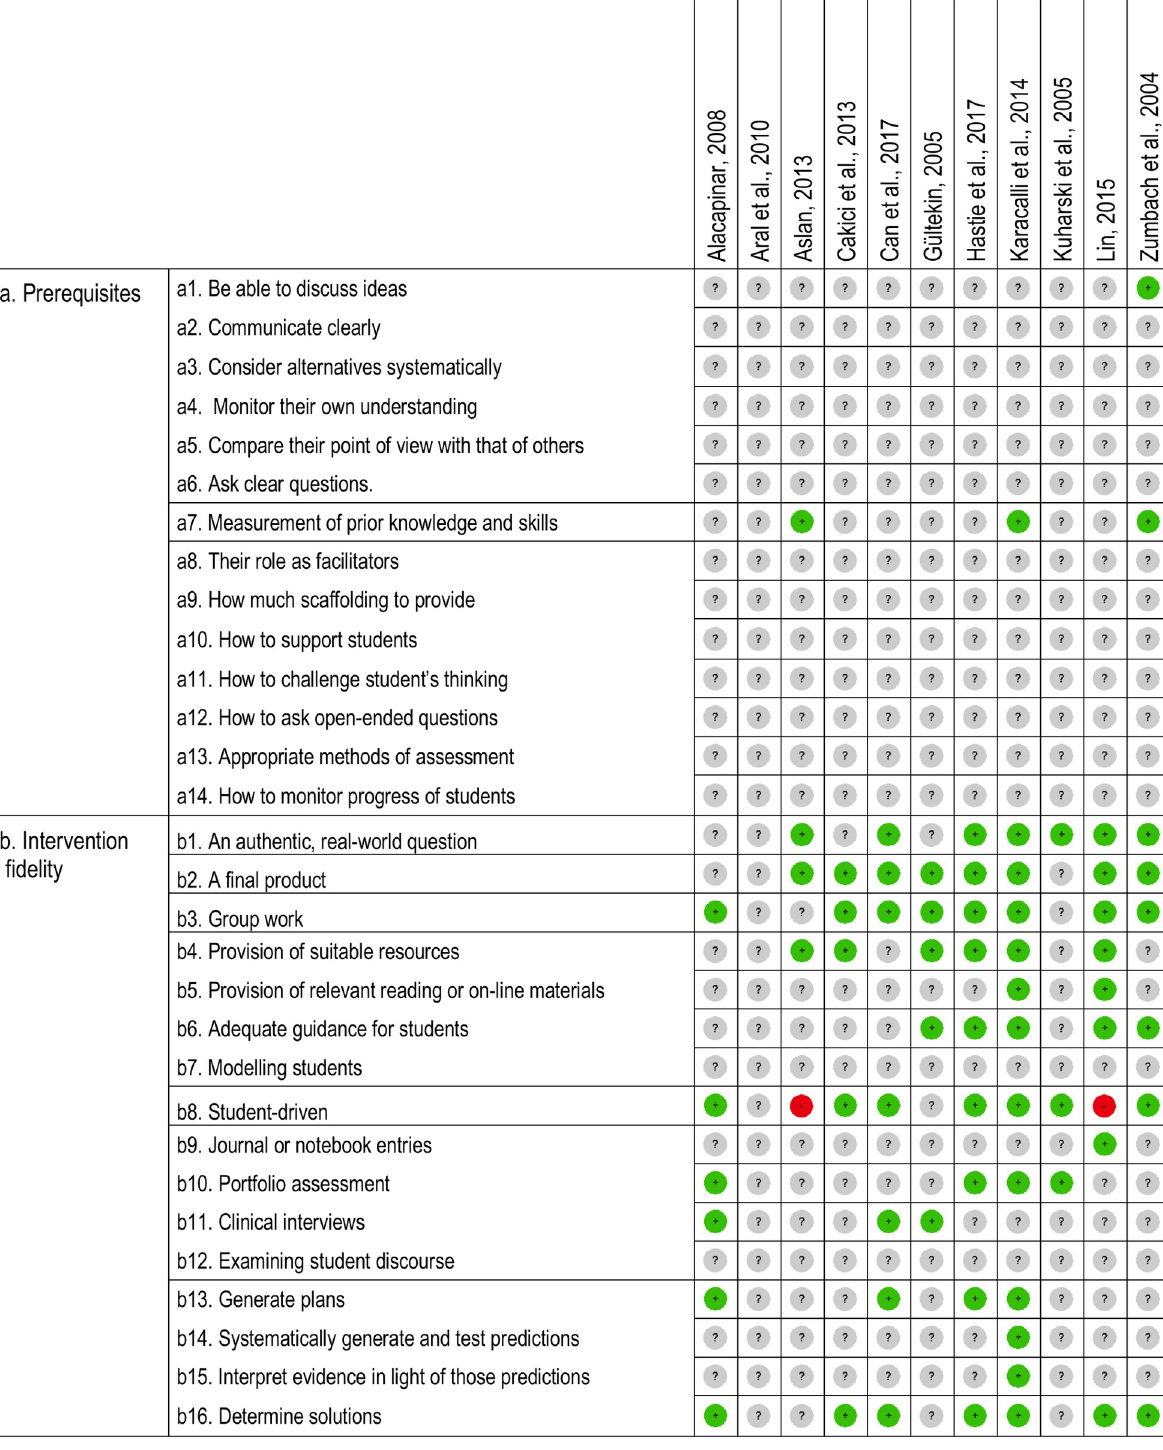
Fig 3. Scale of prerequisites and intervention fidelity. Summary of the prerequisites necessary for students and teachers for a successful PjBL adoption and intervention fidelity criteria in light of the key elements of the method.